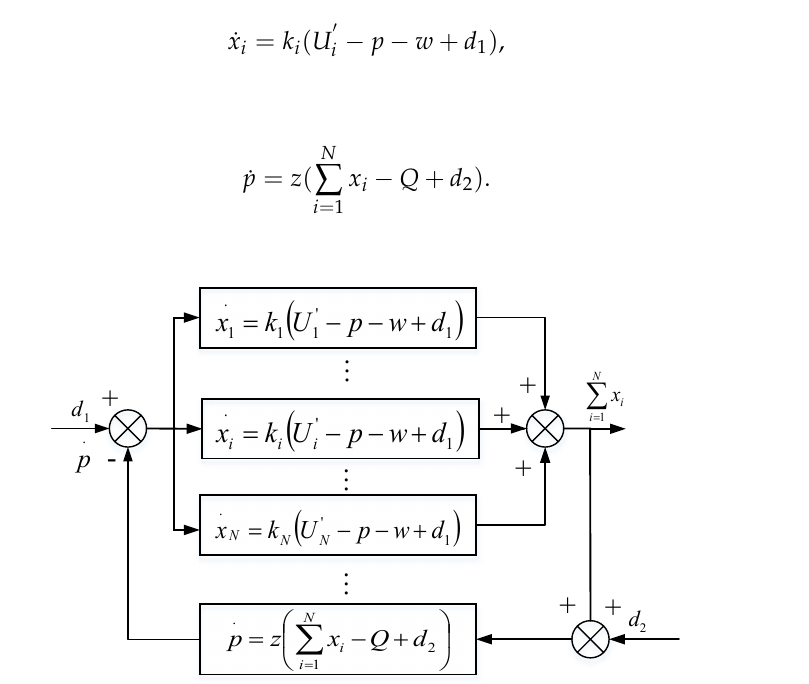
Figure 2. Power management system with additive